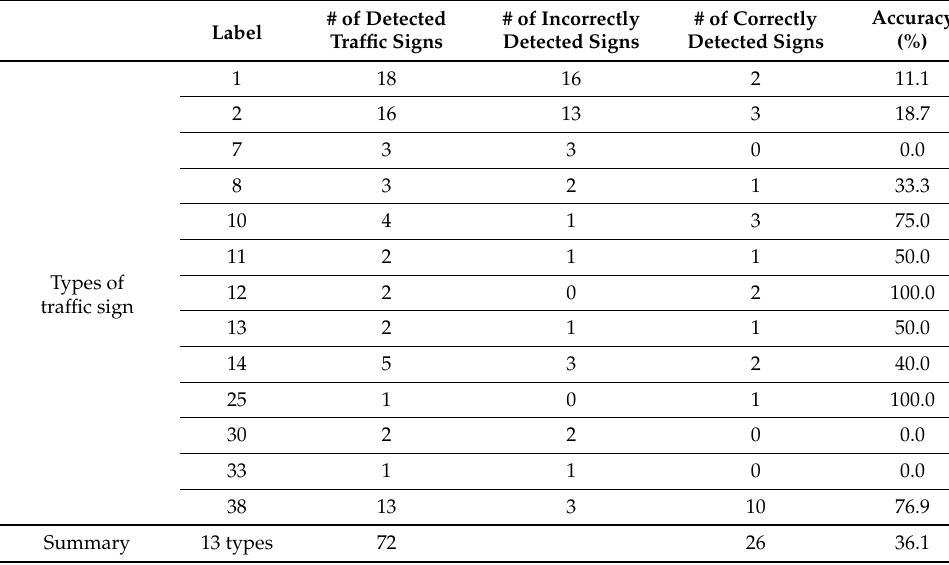
Table 7. Traffic sign recognition results of YOLOv7 using